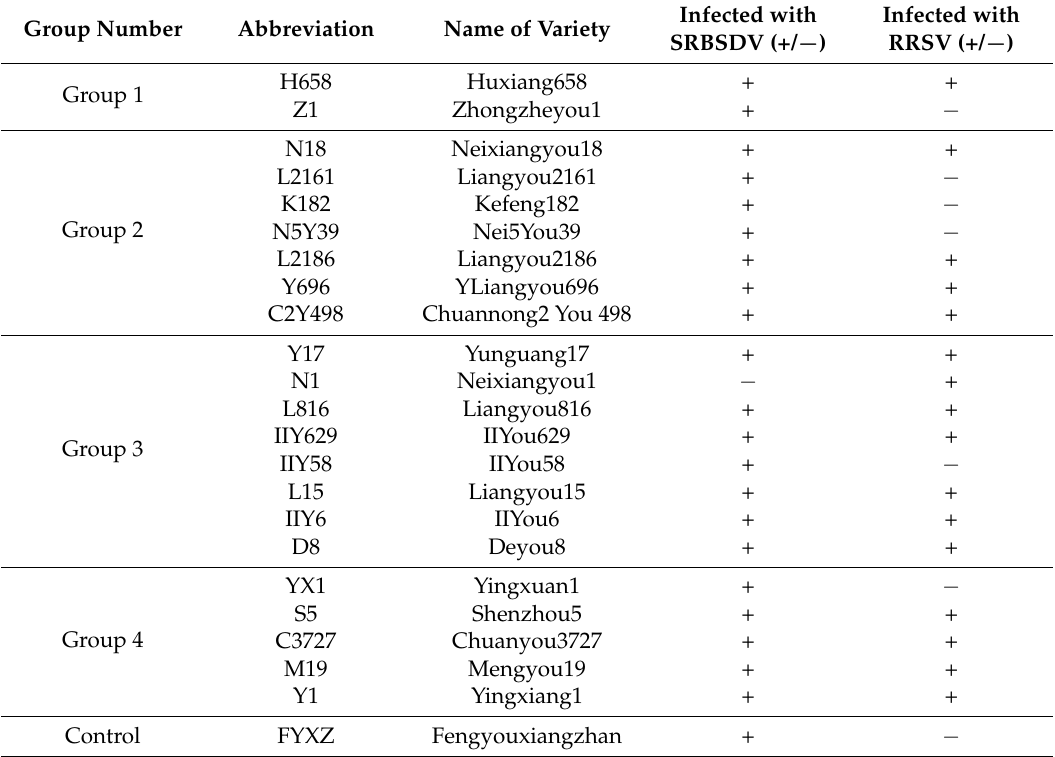
Table 1. 22 Rice varieties tested in Jiucheng in